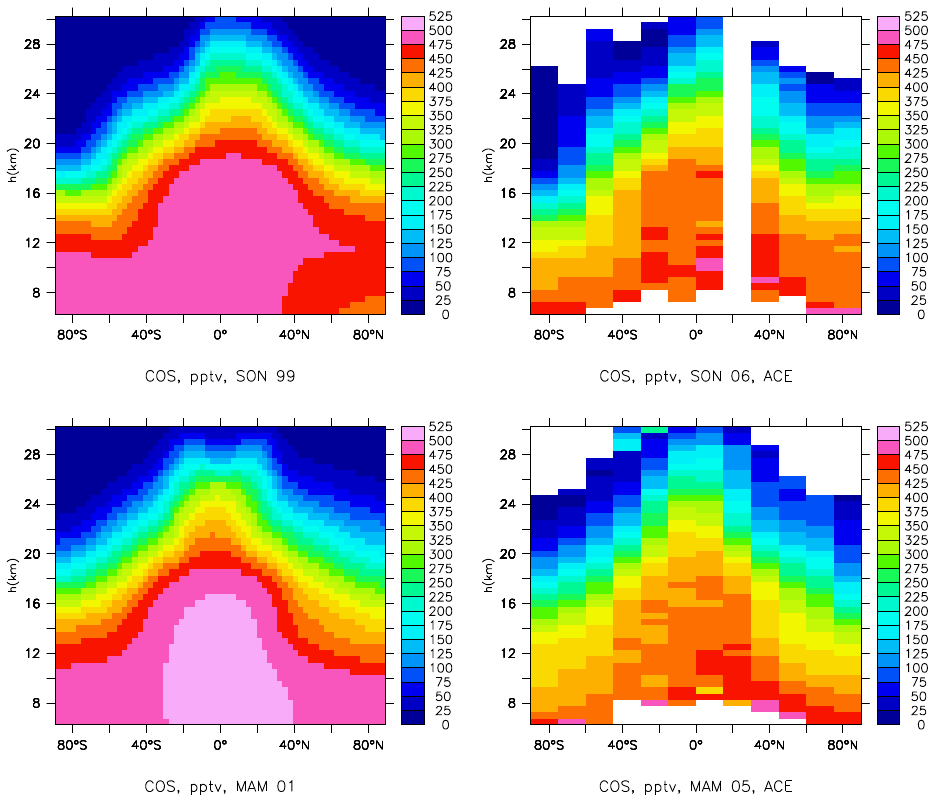
Fig. 2. Simulated zonal mean COS mixing ratios (inpptv) for September to November 1999 and March to May 2001 (left). ACE observations for SON 2006 and MAM 2005 (taken from Barkley et al. (2008), data of their Fig. 3, right).